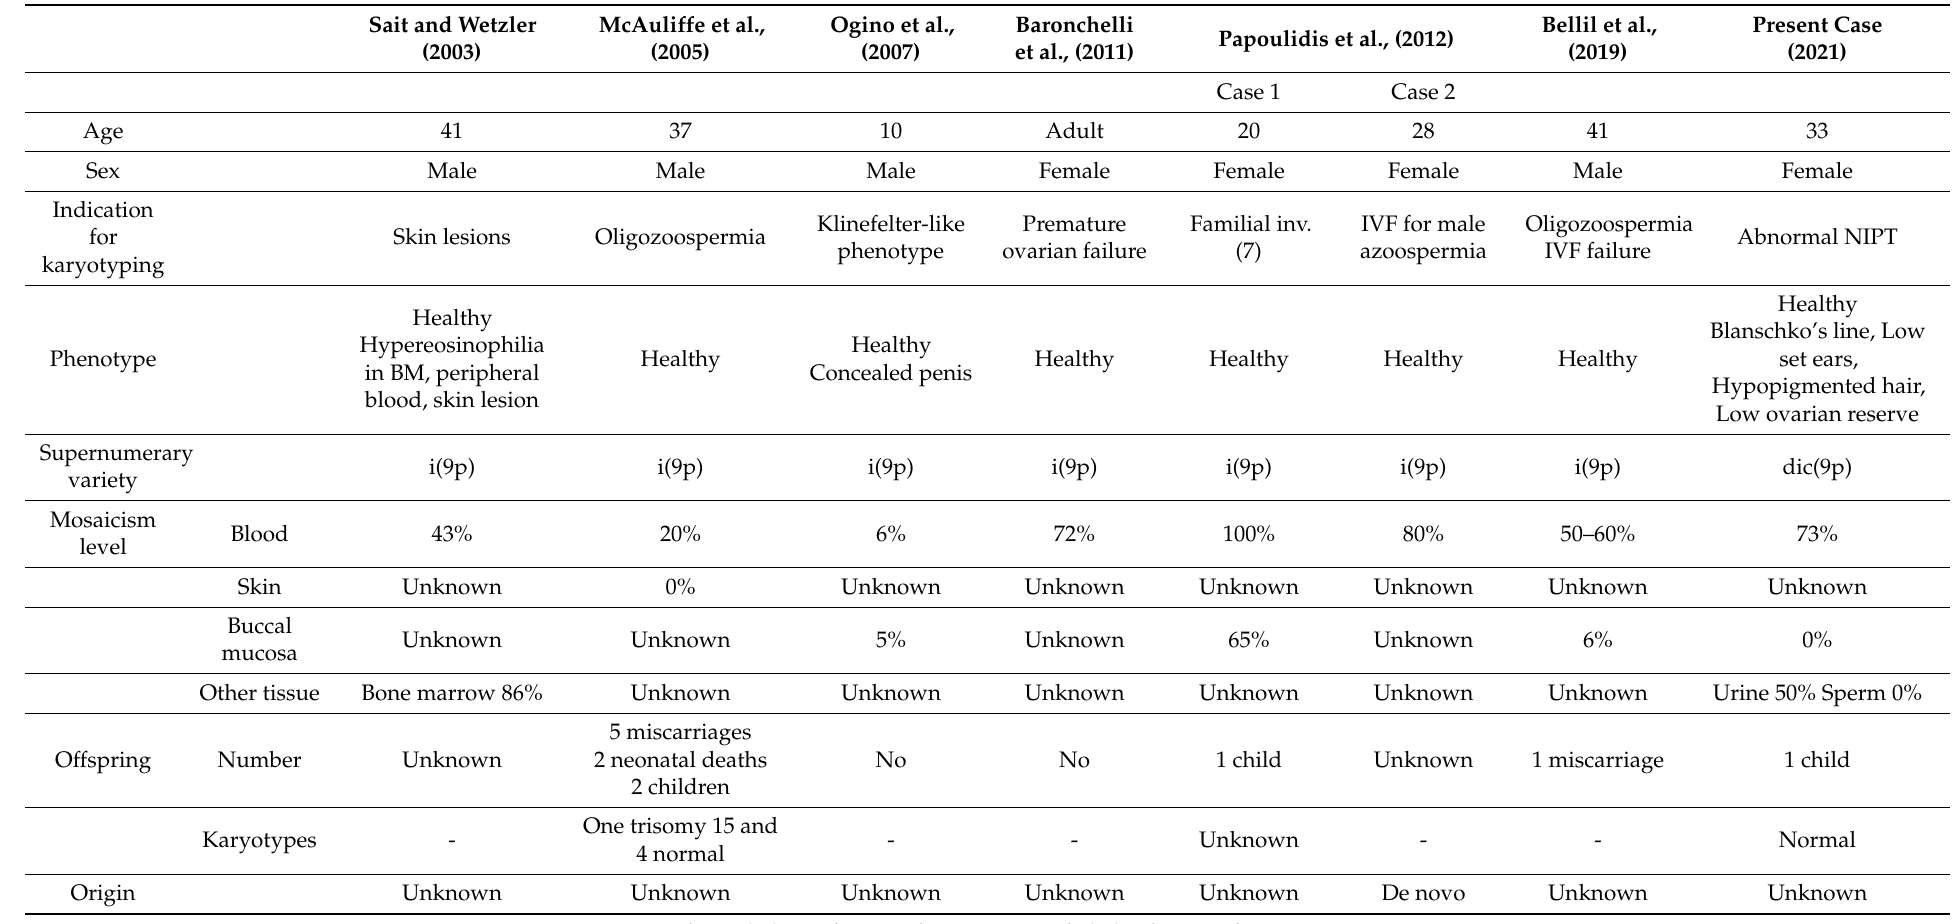
Table 1. Cytogenetic results and clinical data in mosaic tetrasomy